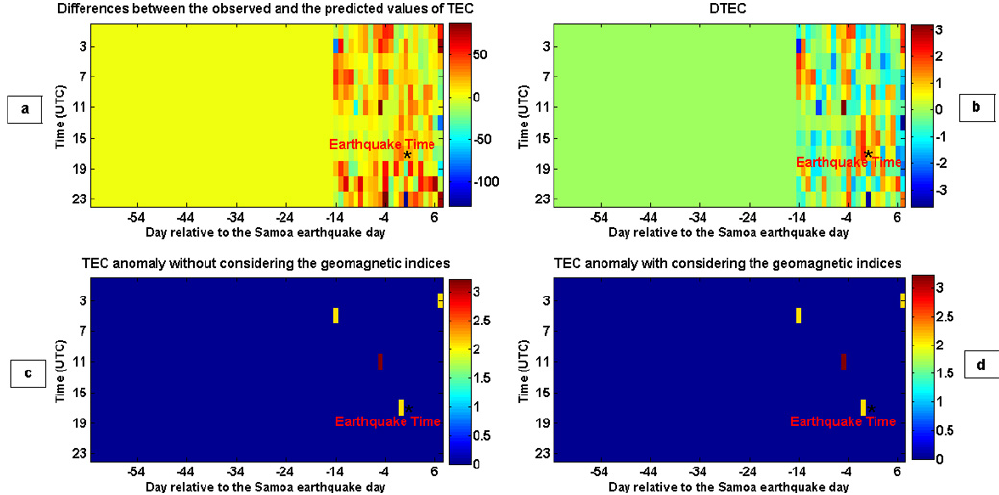
Fig. 11. (a) Differences between the observed and the predicted values of TEC. (b) DTEC variations. (c) Detected anomalies without considering the geomagnetic indices. (d) Detected anomalies with considering the geomagnetic indices.